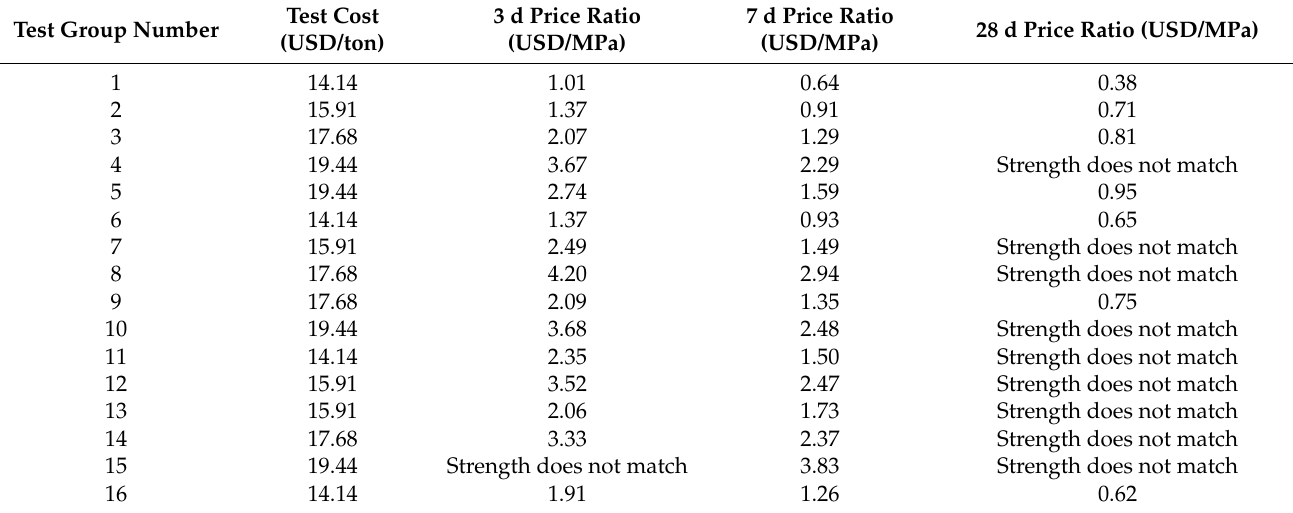
Table 10. Price ratio of different curing times.